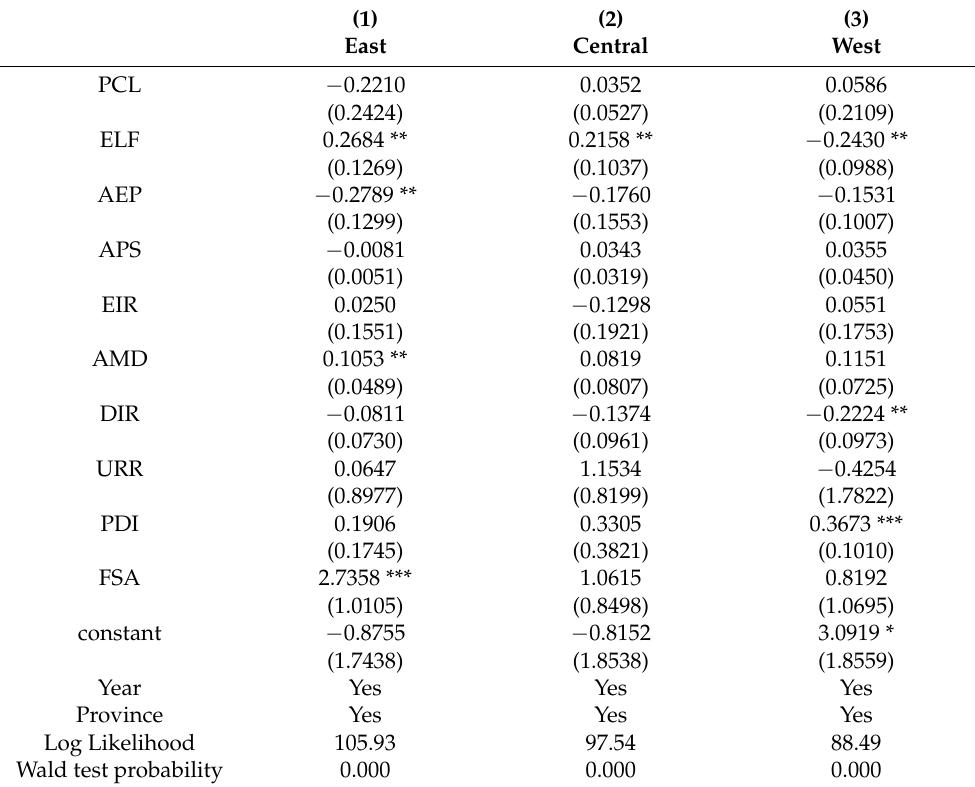
Table 5. Heterogeneity Analysis of Factors Affecting Rice Production